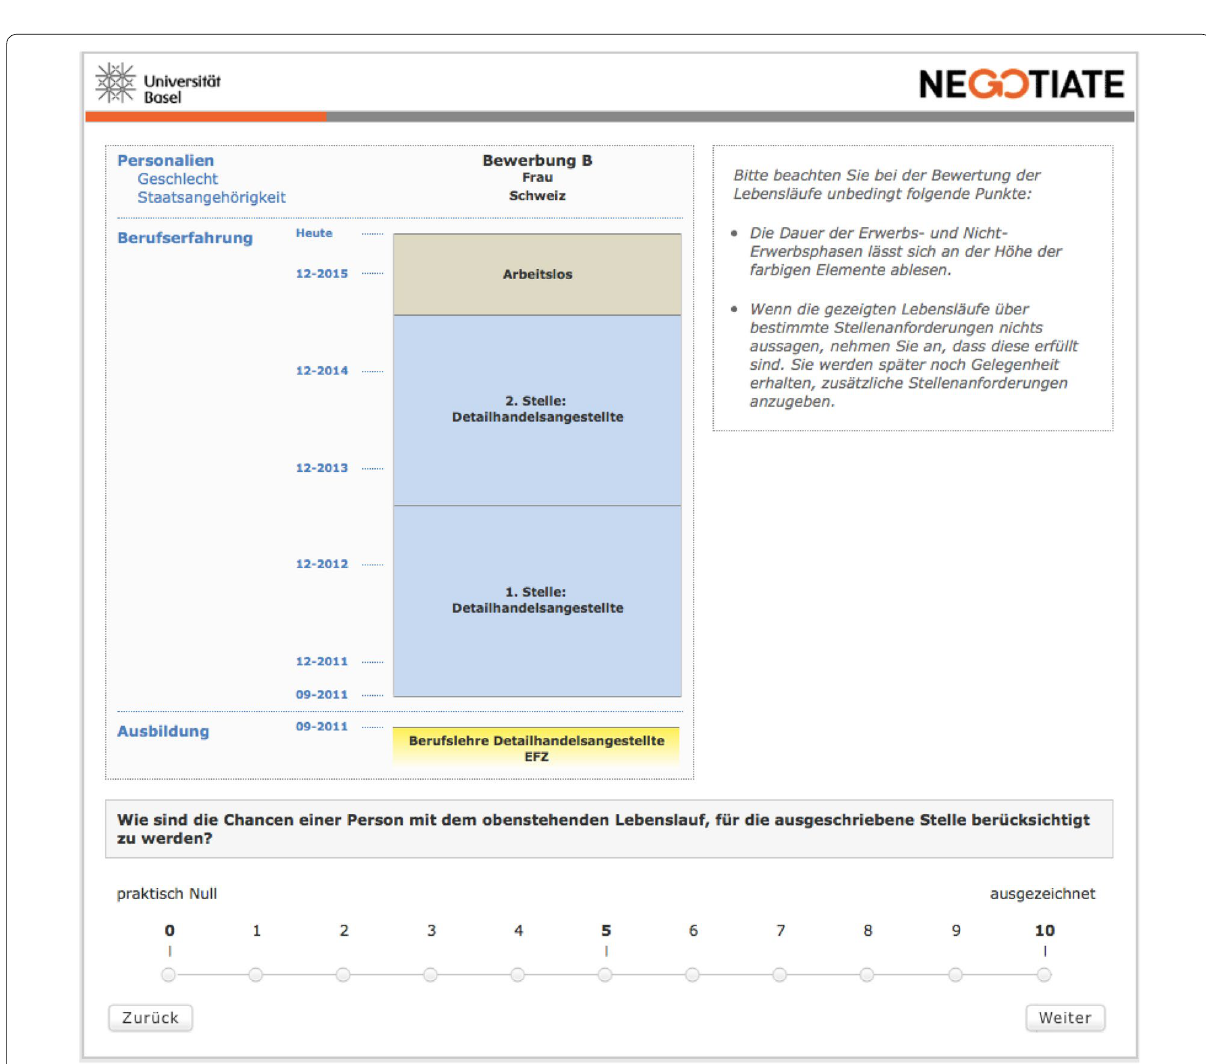
Fig. 1 Illustration of a fictive